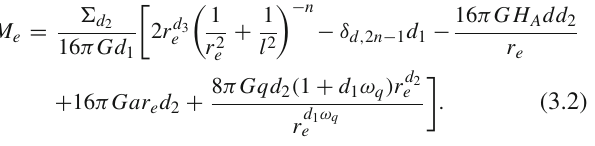
Fig. 2 The plot of g ( r ) (Eq. (2.28)) vs r for fixed values of l = 1, M = 10 3 , δ d , 2 n − 1 = 100, ω = − 0 . 7, (cid:13) = 1, n = 2, q d − 2 d = 6 and H A = 0 .